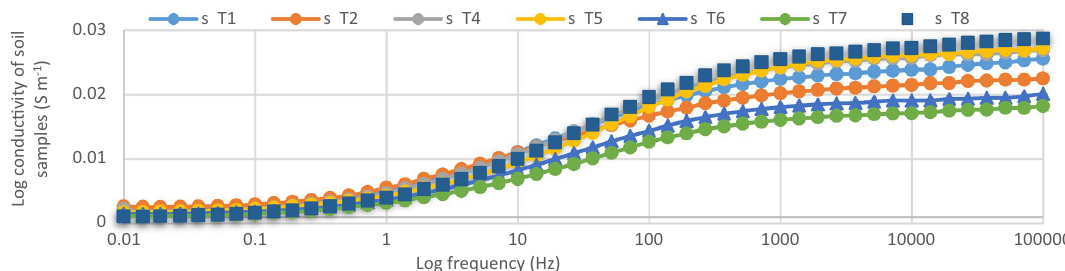
Figure 7. Conductivity of soil samples after second fertilization (40 days after transplanting) within 0.01 Hz and 100 kHz.